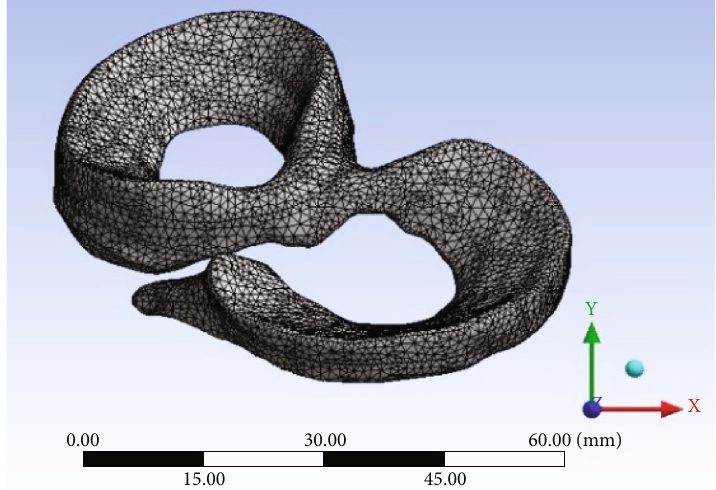
Figure 3: FEM mesh of the meniscus.